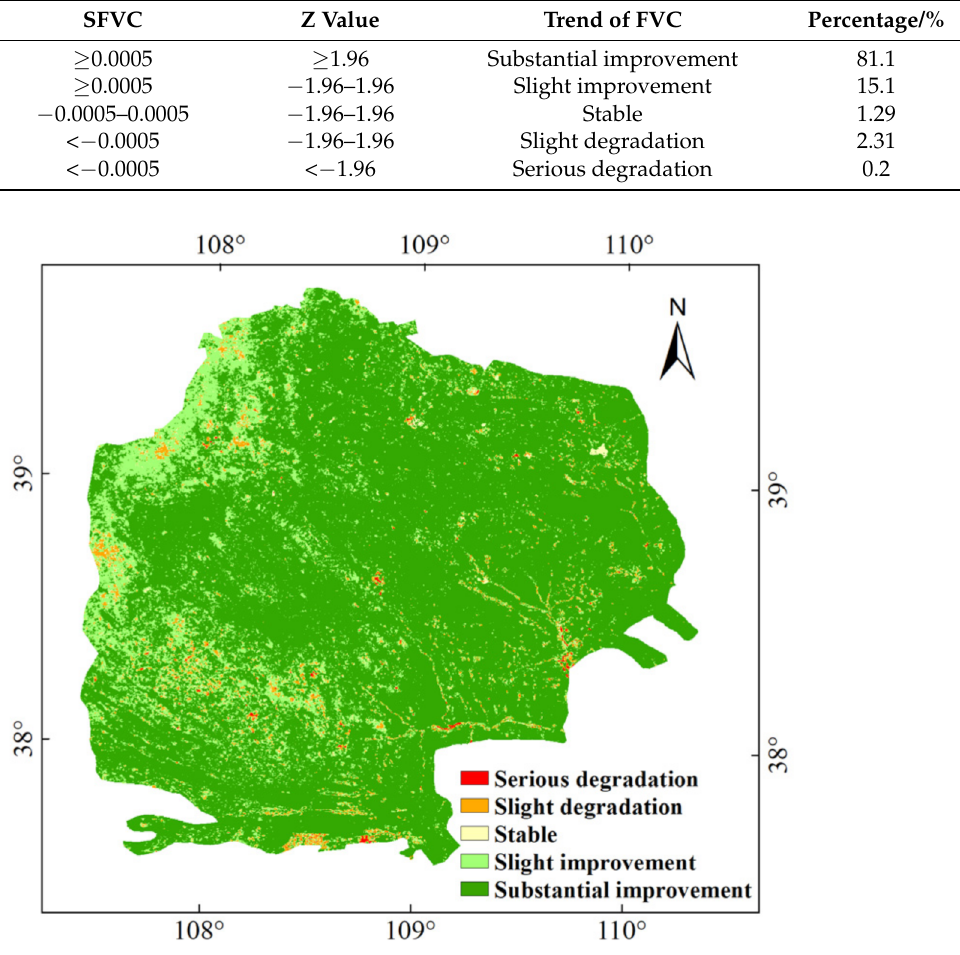
Figure 4. The spatial distribution characteristics of the FVC variation in the Mu Us Sandy